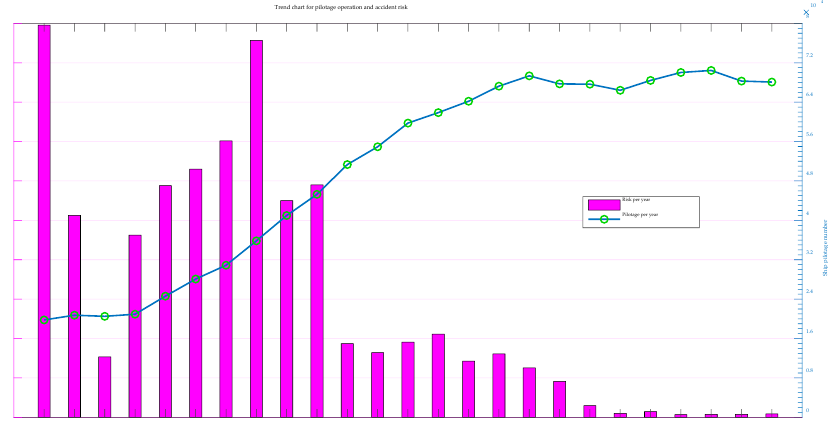
Figure 1. Ship pilotage number and accident risk in the Shanghai port from 1995 to 2019.